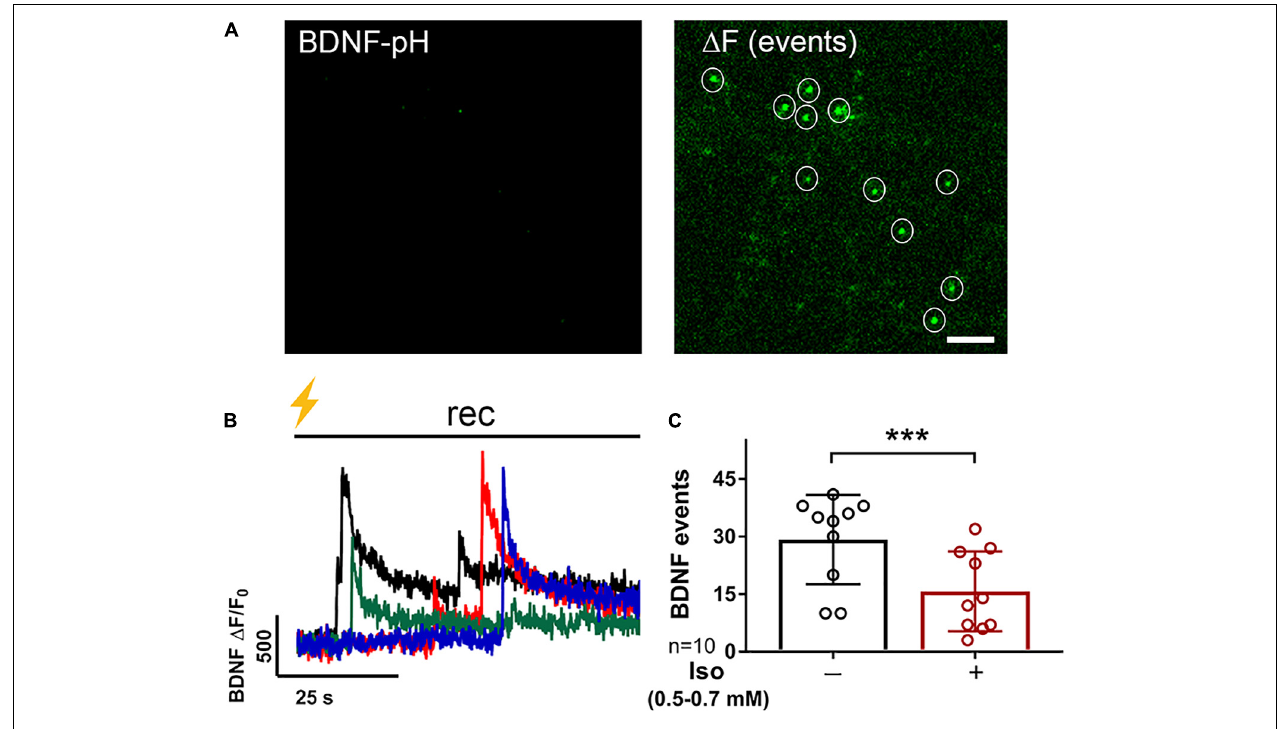
FIGURE 3 | BDNF exocytosis is reduced by isoflurane. Representative images of rat hippocampal neurons (18DIV) transfected with mCherry (not shown) and BDNF-pH showing single BDNF exocytotic events (white circles) before (A , left) and after ( A , right) tetanic stimulation ( B , lightning bolt) showing asynchronous release of BDNF-pH ( B , left). Individual traces represent single BDNF exocytosis shown in different colors. Quantification of BDNF exocytosis defined using fluorescence responses to tetanic stimulation showed inhibition by 0.5–0.7 mM isoflurane (C) (*** p < 0.001 by Student’s paired t -test). Data are mean ± SD; n = 10 neurons per experimental group and 23–113 BDNF events selected for each condition. Scale bar = 5 µ